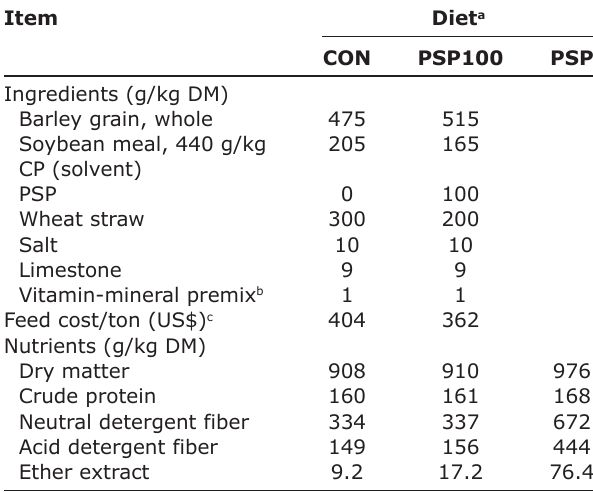
Table-1: Ingredients and chemical composition of diets-containing PSP fed to Awassi lambs.